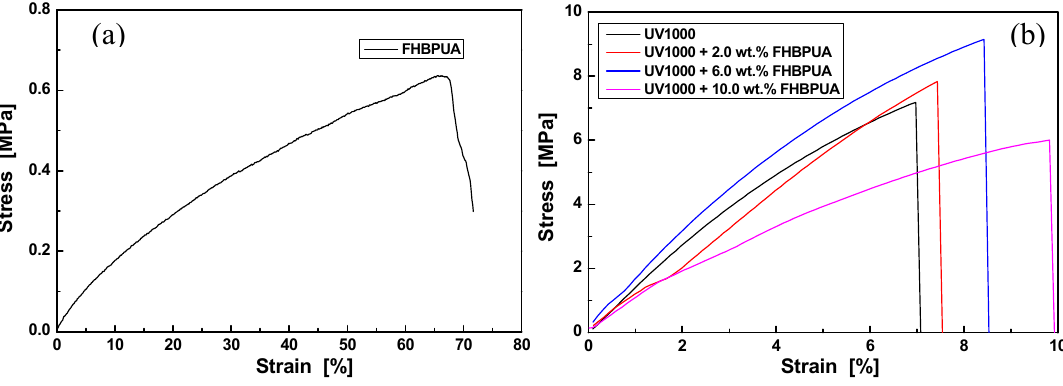
Figure 4. Tensile stress-strain curves of UV-cured film ( a ) FHBPUA and ( b ) UV1000 resin.